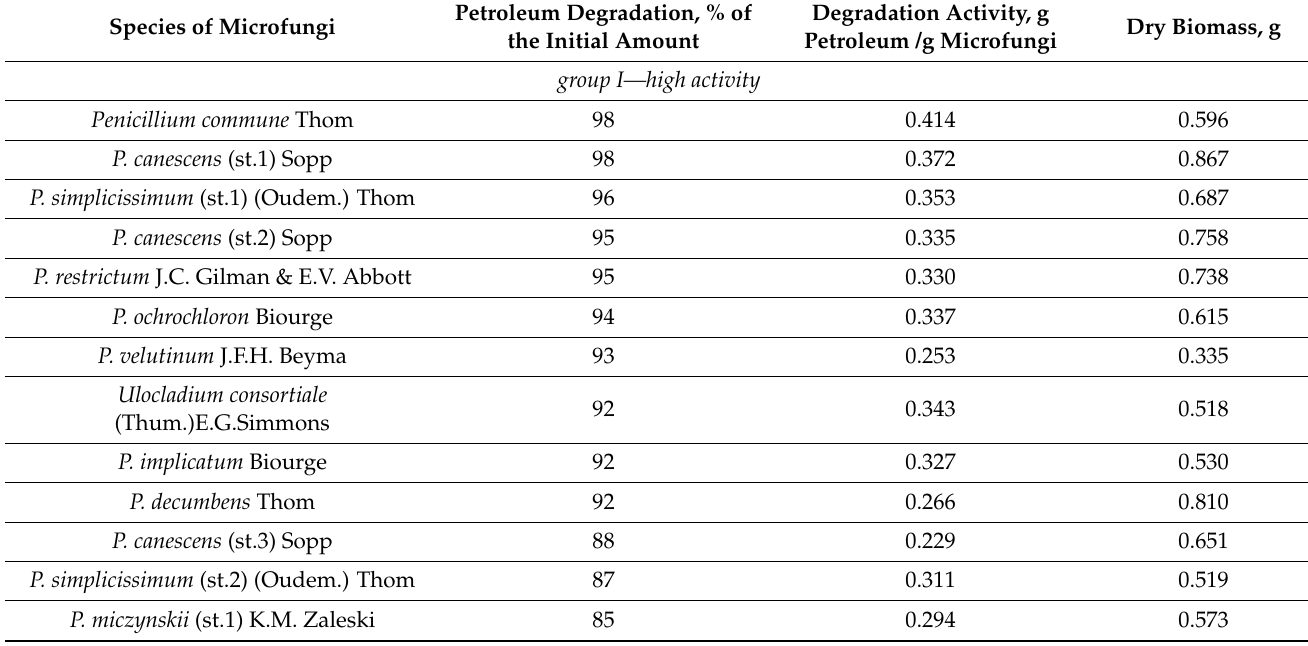
Table 2. Hydrocarbon oxidizing activity of fungi species for 14 days (the initial concentration of petroleum products is 1% by volume in the